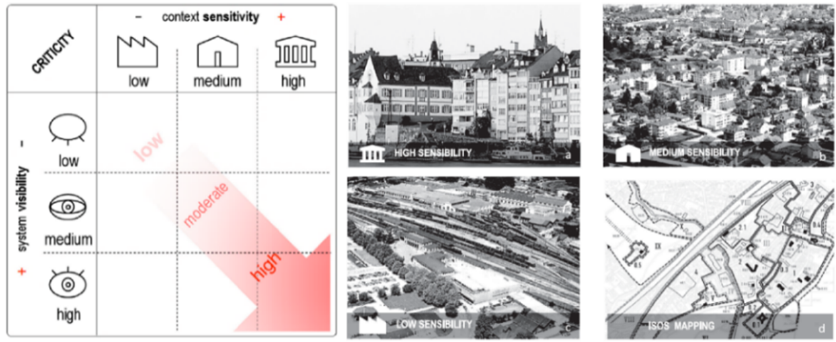
Figure 2. Levels of integration quality of the solar system. Reproduced with permission from Maria Cristina Munari Probst, Christian Roecker, Solar Energy; published by Elsevier, 2019 [15,24].